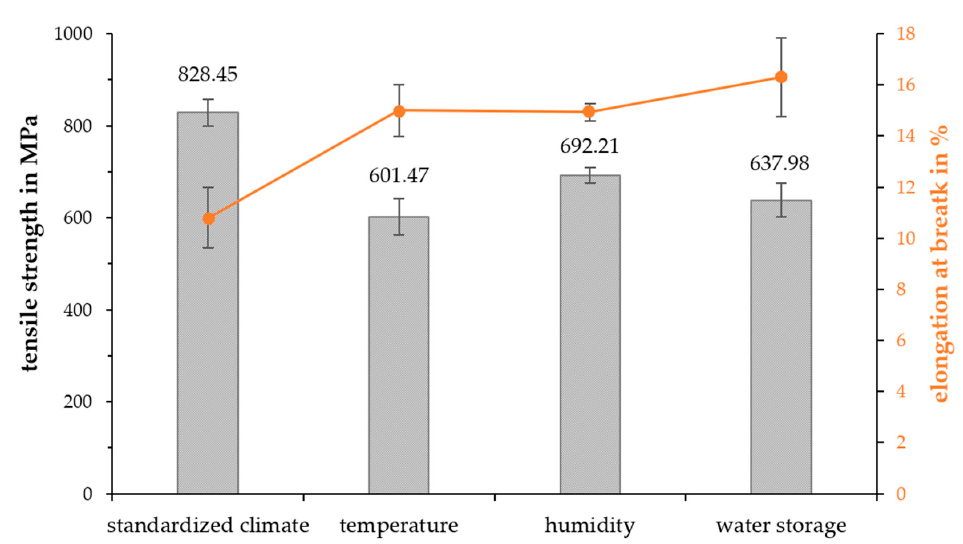
Figure 9. Single-fiber tensile strength of the aged RCF.